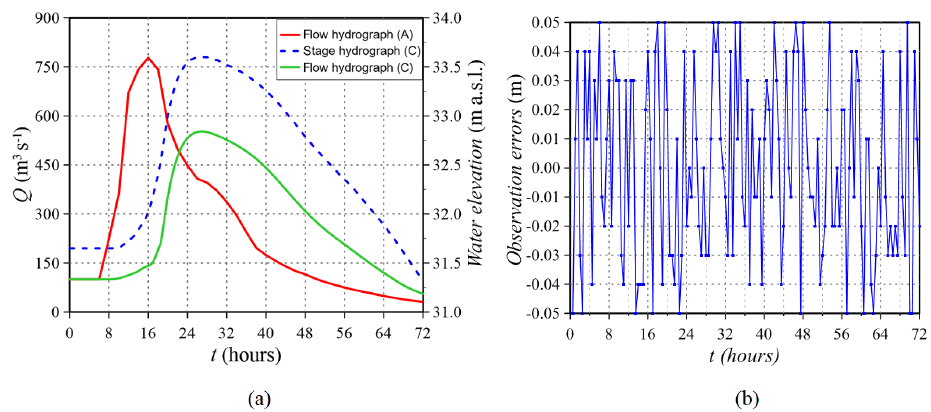
Figure 12. Secchia River: flow hydrograph in section A and flow and stage hydrographs in section C (a) and observation error distribution (b) .